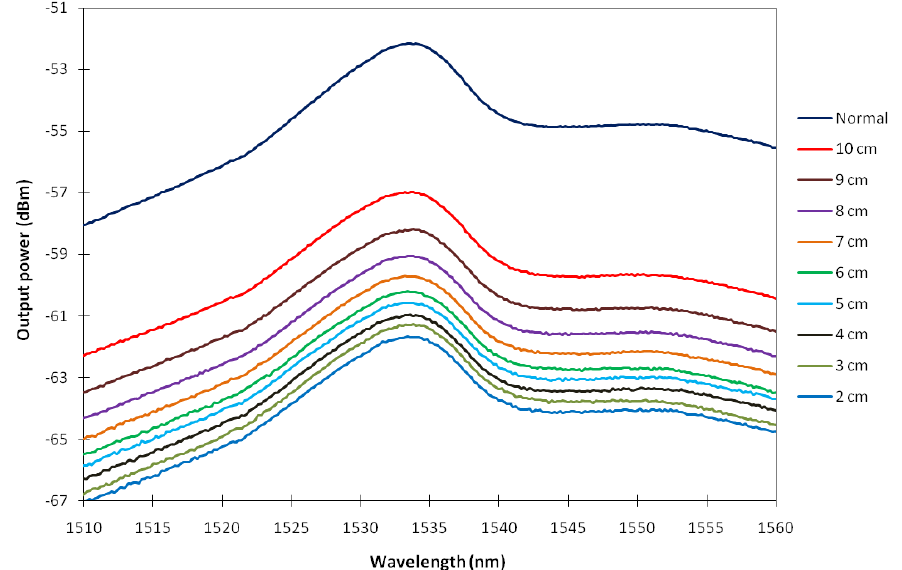
Figure 3. The ASE spectrum level of the BSEDF for different spooling